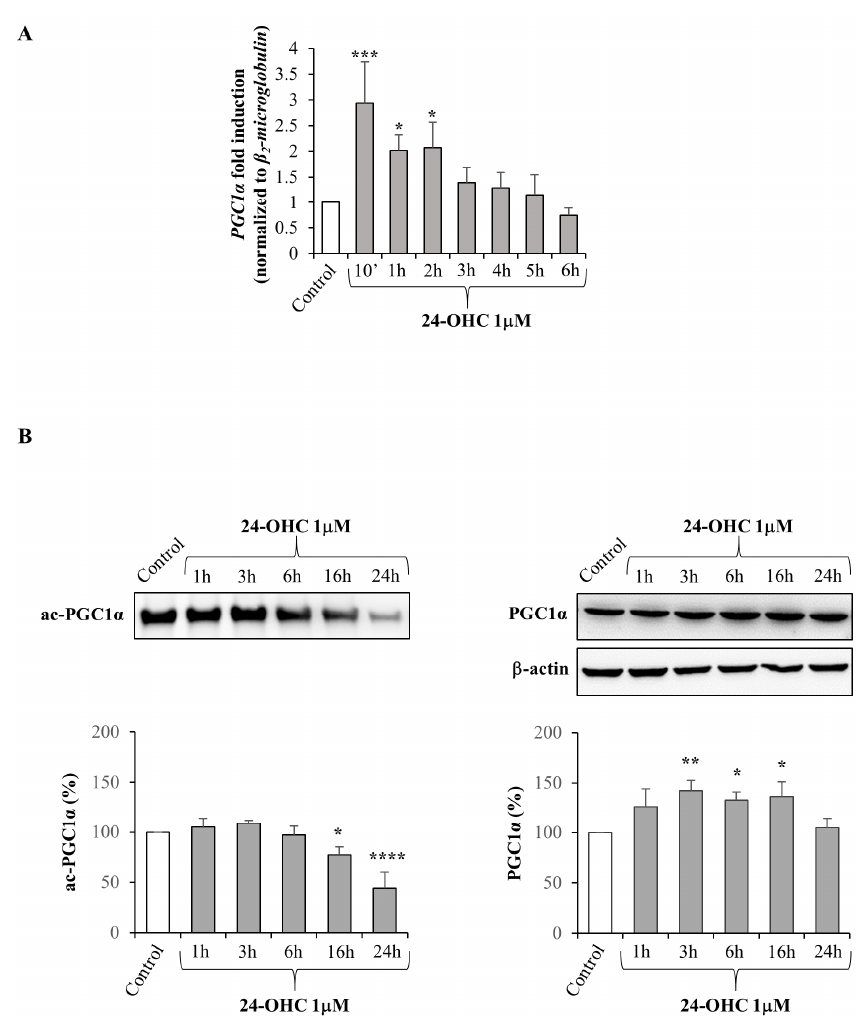
Figure 1. Effect of 24-OHC on PGC1 α expression and on the levels of acetylated and total PGC1 α in SK-N-BE cells. ( A ) PGC1 α gene expression was quantified by real-time RT-PCR in cells treated with 24-OHC (1 µ M) up to 6 h. Data, normalized to the corresponding β 2 -microglobulin, are expressed as mean values ± SD of three different experiments. * p < 0.05 and *** p < 0.001 vs. control. ( B ) Acetylated PGC1 α (ac-PGC1 α ) and total PGC1 α protein levels were analyzed by Western blotting in cells treated with 1 μ M 24-OHC up to 24 h. Representative blots are shown. The histograms represent mean values ± SD of three experiments. Total PGC1 α levels were normalized to the corresponding β -actin levels. Densitometric measurements are expressed as percentage of control value. * p < 0.05, ** p < 0.01, **** p < 0.0001 vs. control.